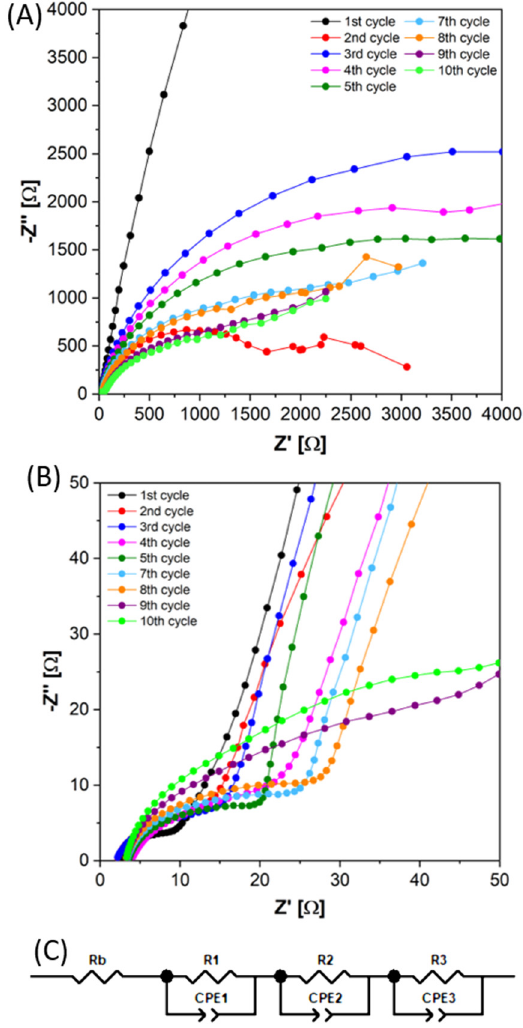
Figure 4. Nyquist plot for cells based on the MoS 2 anode: ( A ) Complete spectrum; ( B ) High frequency area. ( C ) Equivalent circuit used to fit the EIS spectra of MoS 2 -based PIBs during the forming stage.